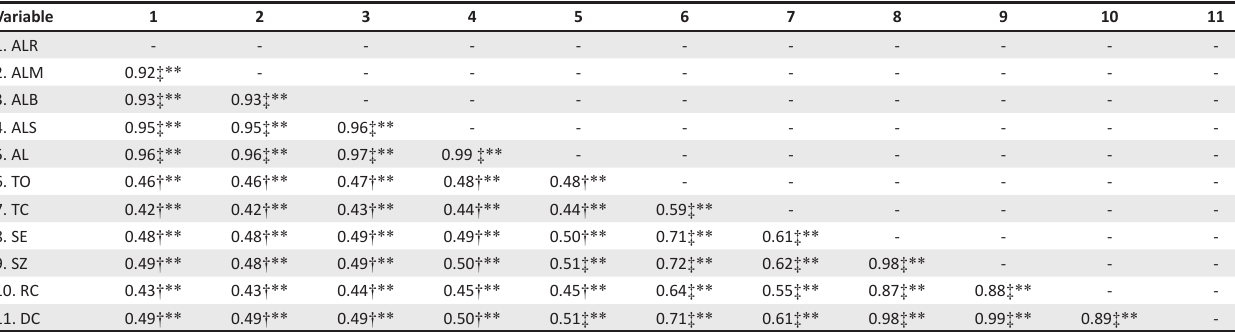
TABLE 5: Correlation matrix. Variable